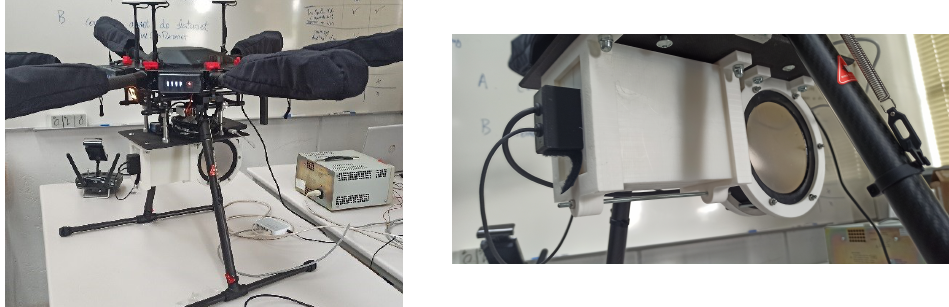
Figure 5. Radiation detection system integrated in the DJI Matrice 600 Pro